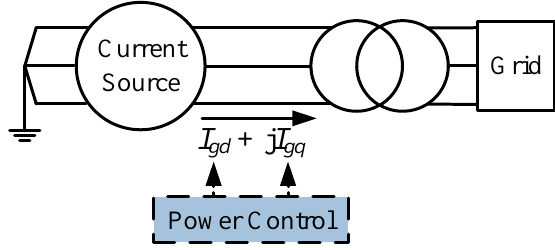
Figure 2. Controlled current source model of a PMSG.